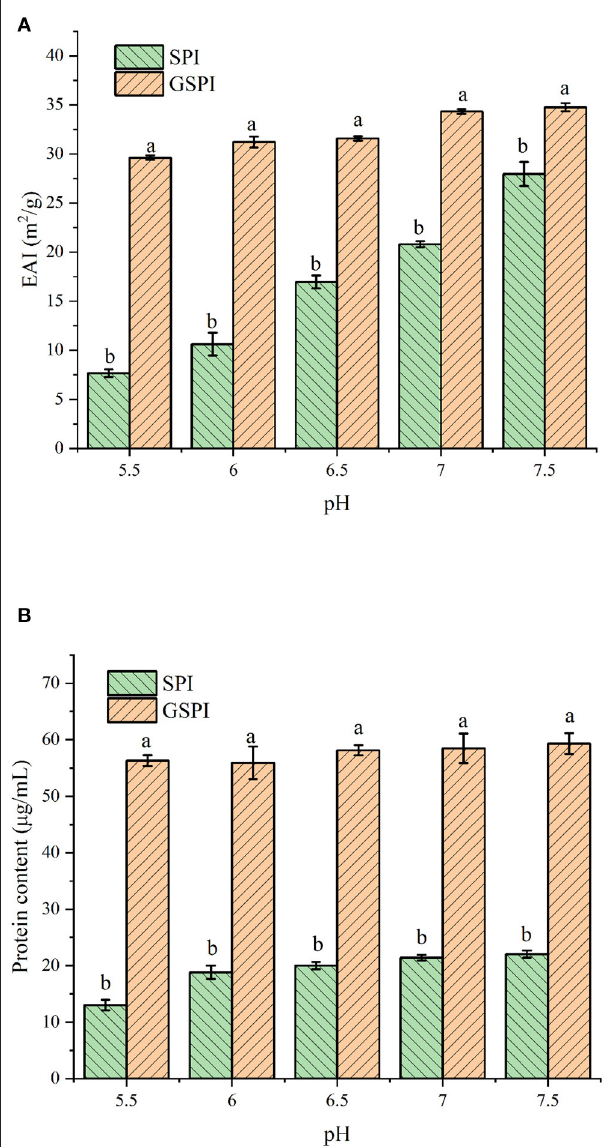
FIGURE 2 | (A) Emulsification of SPI and GSPI at pH 5.5–7.5. (B) Solubility of SPI and GSPI at pH 5.5–7.5. Different letters indicate significant differences between SPI and GSPI at the same